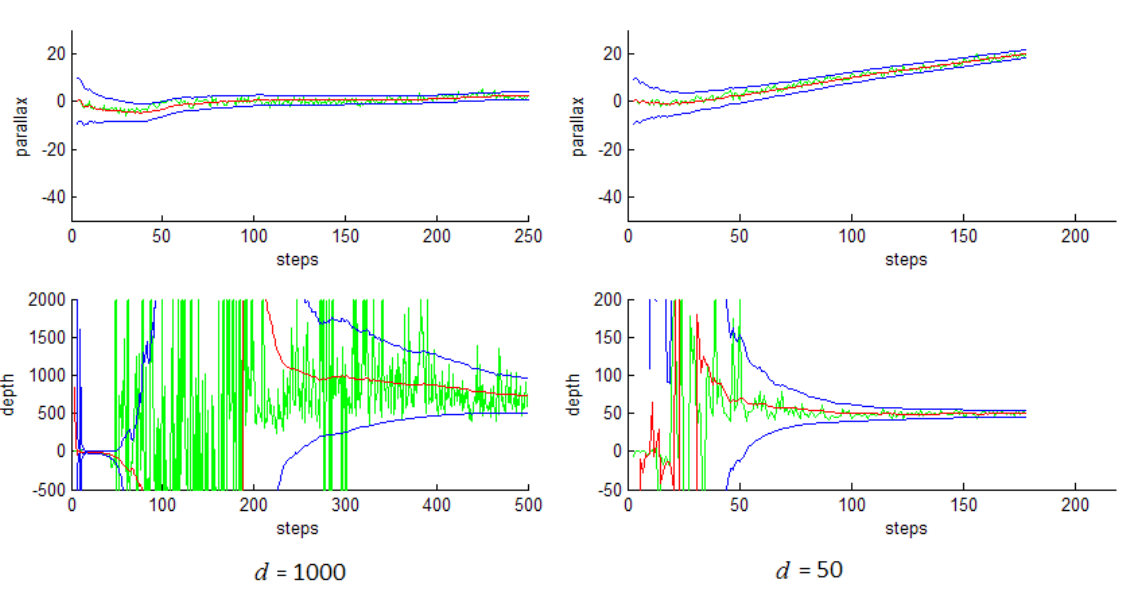
Figure 6. Parallax and depth estimations for a distant and a close